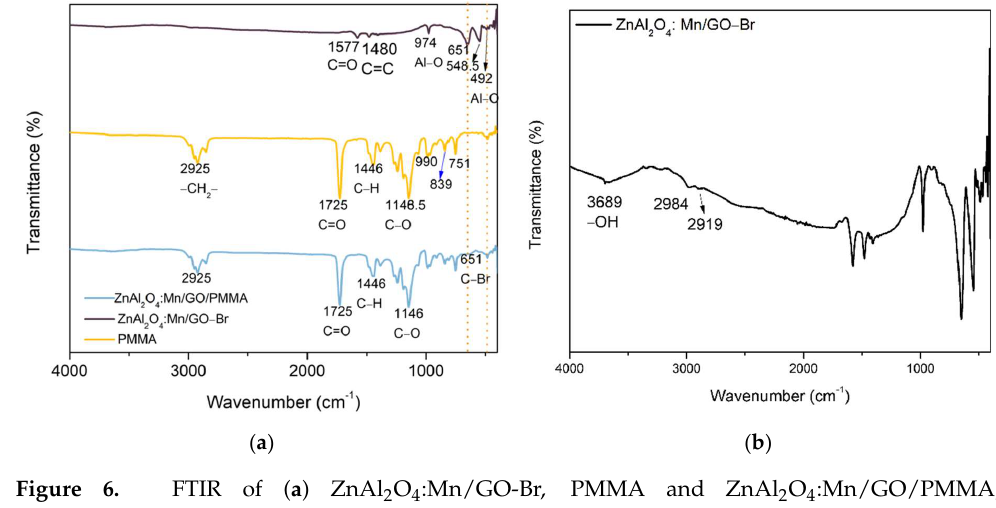
Figure 6. FTIR of ( a ) ZnAl 2 O 4 :Mn/GO-Br, PMMA and ZnAl 2 O 4 :Mn/GO/PMMA; ( b ) FTIR of ( a ) ZnAl 2 O 4 :Mn/GO-Br, PMMA and ZnAl 2 O 4 :Mn/GO/PMMA; ZnAl 2 O 4 :Mn/GO-Br. ( b ) ZnAl 2 O 4 :Mn/GO-Br. FTIR for ZnAl 2 O 4 :Mn/GO-Br, ZnAl 2 O 4 : Mn/GO-Br/PMMA, and PMMA is shown Figure 6. The FTIR results prove that the active group of ATRP -Br is located on the surface of GO. The FTIR pattern of ZnAl 2 O 4 : Mn/GO-Br displays a peak at 651 cm −1 , representing C-Br, which reveals the existence of a connection between GO and the active group, -Br. The peaks at 1577 cm −1 and 1480 cm −1 correspond to the vibration of O-C=O and C-H of GO. Compared with PMMA polymerized through ATRP, the weak peak at 651 cm −1 re- veals the formation of the active group, C-Br, during the polymerization from ZnAl 2 O 4 : Mn/GO-Br to the polymer chain. Figure 6b is the FTIR of ZnAl 2 O 4 : Mn/GO-Br, which is clearer to reveal the structure of the product; the peak at 3689 cm −1 refers to the -OH func- tional groups on GO. Peaks at 1577 cm −1 and 1480 cm −1 refer to C=O cm −1 and C=C cm −1 of GO. In conclusion, the FTIR result consists of the SI-ATRP mechanism.